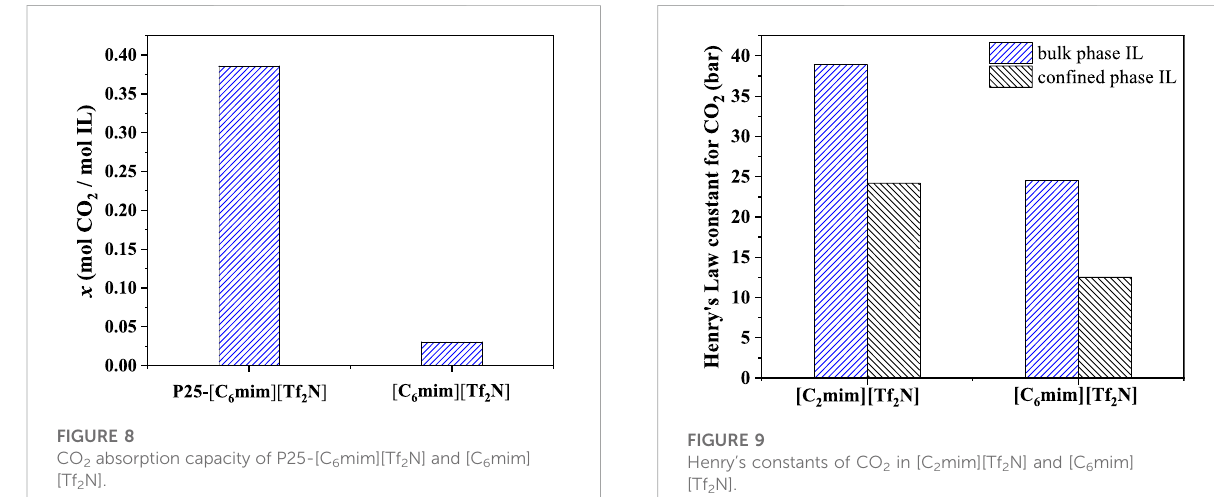
FIGURE 8 CO 2 absorption capacity of P25-[C 6 mim][Tf 2 N] and [C 6 mim] [Tf 2 N].